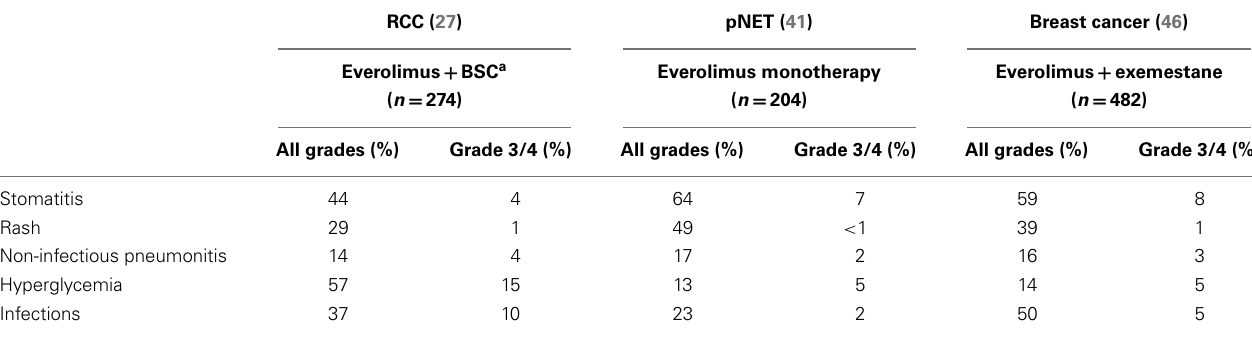
Table 1 | Incidence of the main adverse events (all grades and grade 3/4) reported in the three largest phase III studies of everolimus in advanced solid tumors (RCC, pNET, and breast cancer)